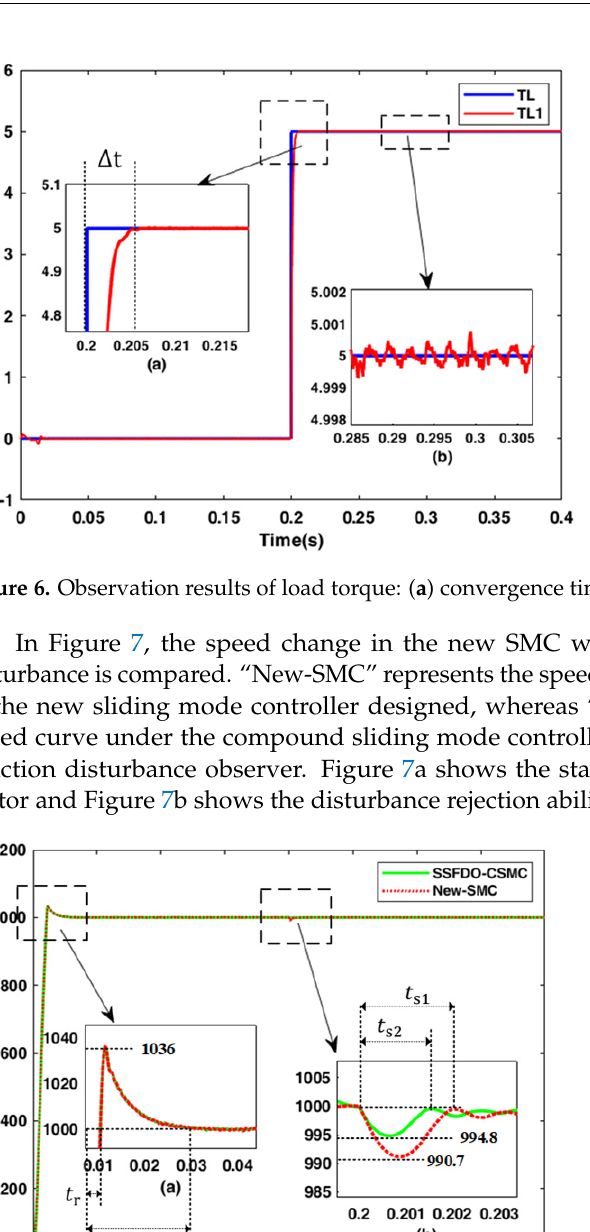
Figure 6. Observation results of load torque: ( a ) convergence time, ( b ) torque fluctuation